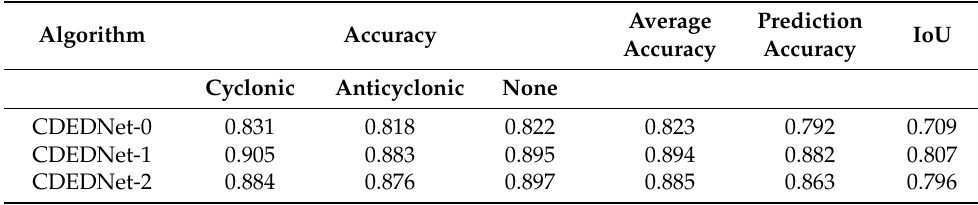
Figure 7. Comparison of eddy detection results. ( a ) Original current field; ( b ) Ground truth eddies; ( c ) Eddies detected by CEDENet-0; ( d ) Eddies detected by CEDENet-1; ( e ) Eddies detected by CEDENet-2. The rows are for different data times. From top to bottom: 11:20 28 July, 17:00 14 August, 8:40 25 August, 10:20 8 September, 21:40 27 September, and 12:20 12 October 2017. The dark regions indicate the boundaries of the detected eddies and the red spots depict the eddy centers. Table 1. The accuracy and Intersection over Union (IoU) obtained by CDEDNet-0, CDEDNet-1, and CDEDNet-2 on 30-times